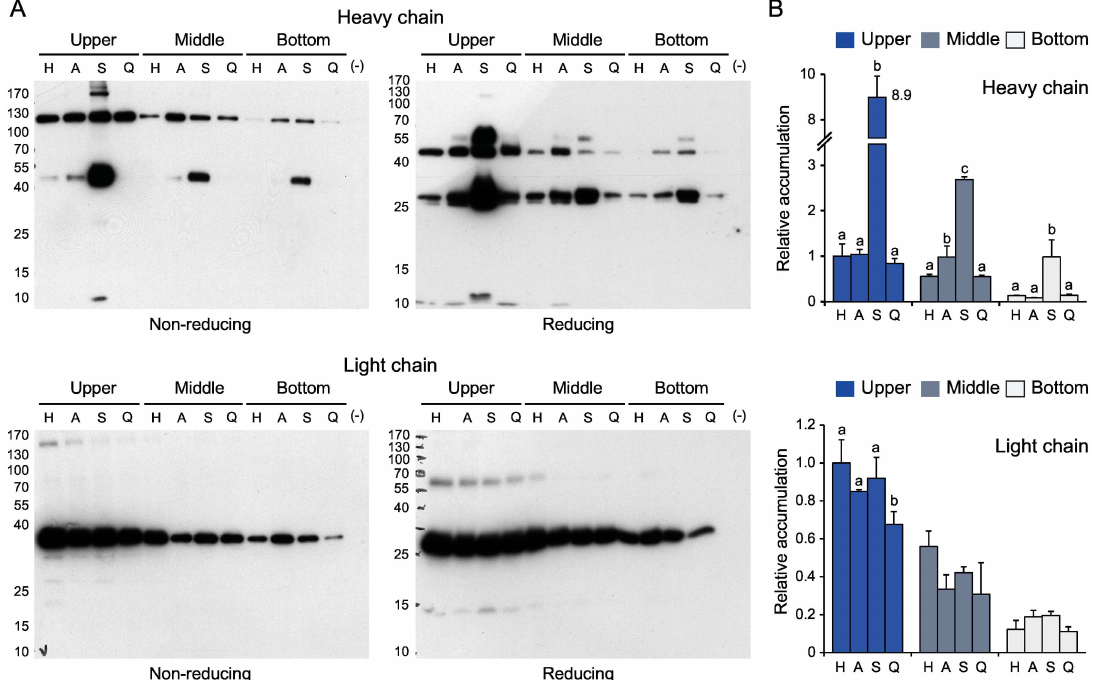
Fig 3. H10 heavy and light chain profiles in upper, middle and bottom leaves of N . benthamiana expressing either polypeptides alone or in combination with an accessory protease inhibitor. A: Representative immunoblots for the H10 heavy and light chains. Leaf protein extracts were submitted to SDS-PAGE in reducing or non-reducing conditions, and then electro-transferred onto nitrocellulose membranes for immunodetection with an anti-human γ chain HRP-conjugated antibody (heavy chain) or an anti-human λ chain HRP-conjugatedantibody(light chain). Numbers on the left show the positionof molecularmass markers (kDa). (–) stands for empty vector-transfected plants (negativecontrols). B: Quantitative ELISA for the H10 heavy and light chains. The two chains were expressedalone(H) or together with α 1 -ACT (A), SlCYS8 (S) or Q47P (Q). Data are expressedcompared to the H alone treatment in upper leaves (arbitrary value of 1.0). Each bar is the mean of three biological replicatevalues ± SE . For each leaf morphologicalzone, bars with different letters are significantly different (post- ANOVA Tukey’s test; P <